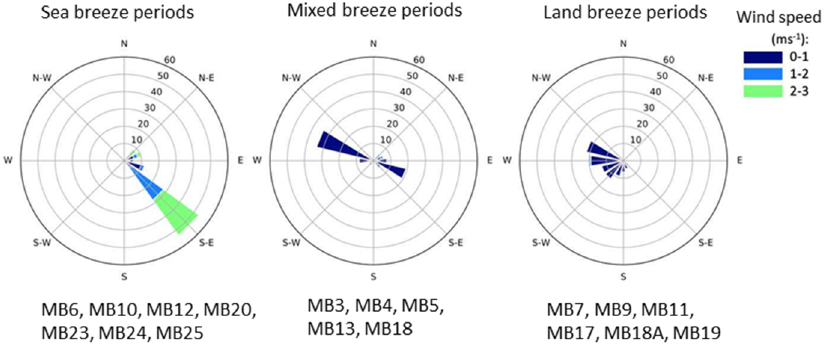
Figure 2. Wind roses recorded during aerosol sampling and corresponding sample IDs. Concentric circles indicate the relative proportion (in percent) of the time when wind blowed from a specific direction.